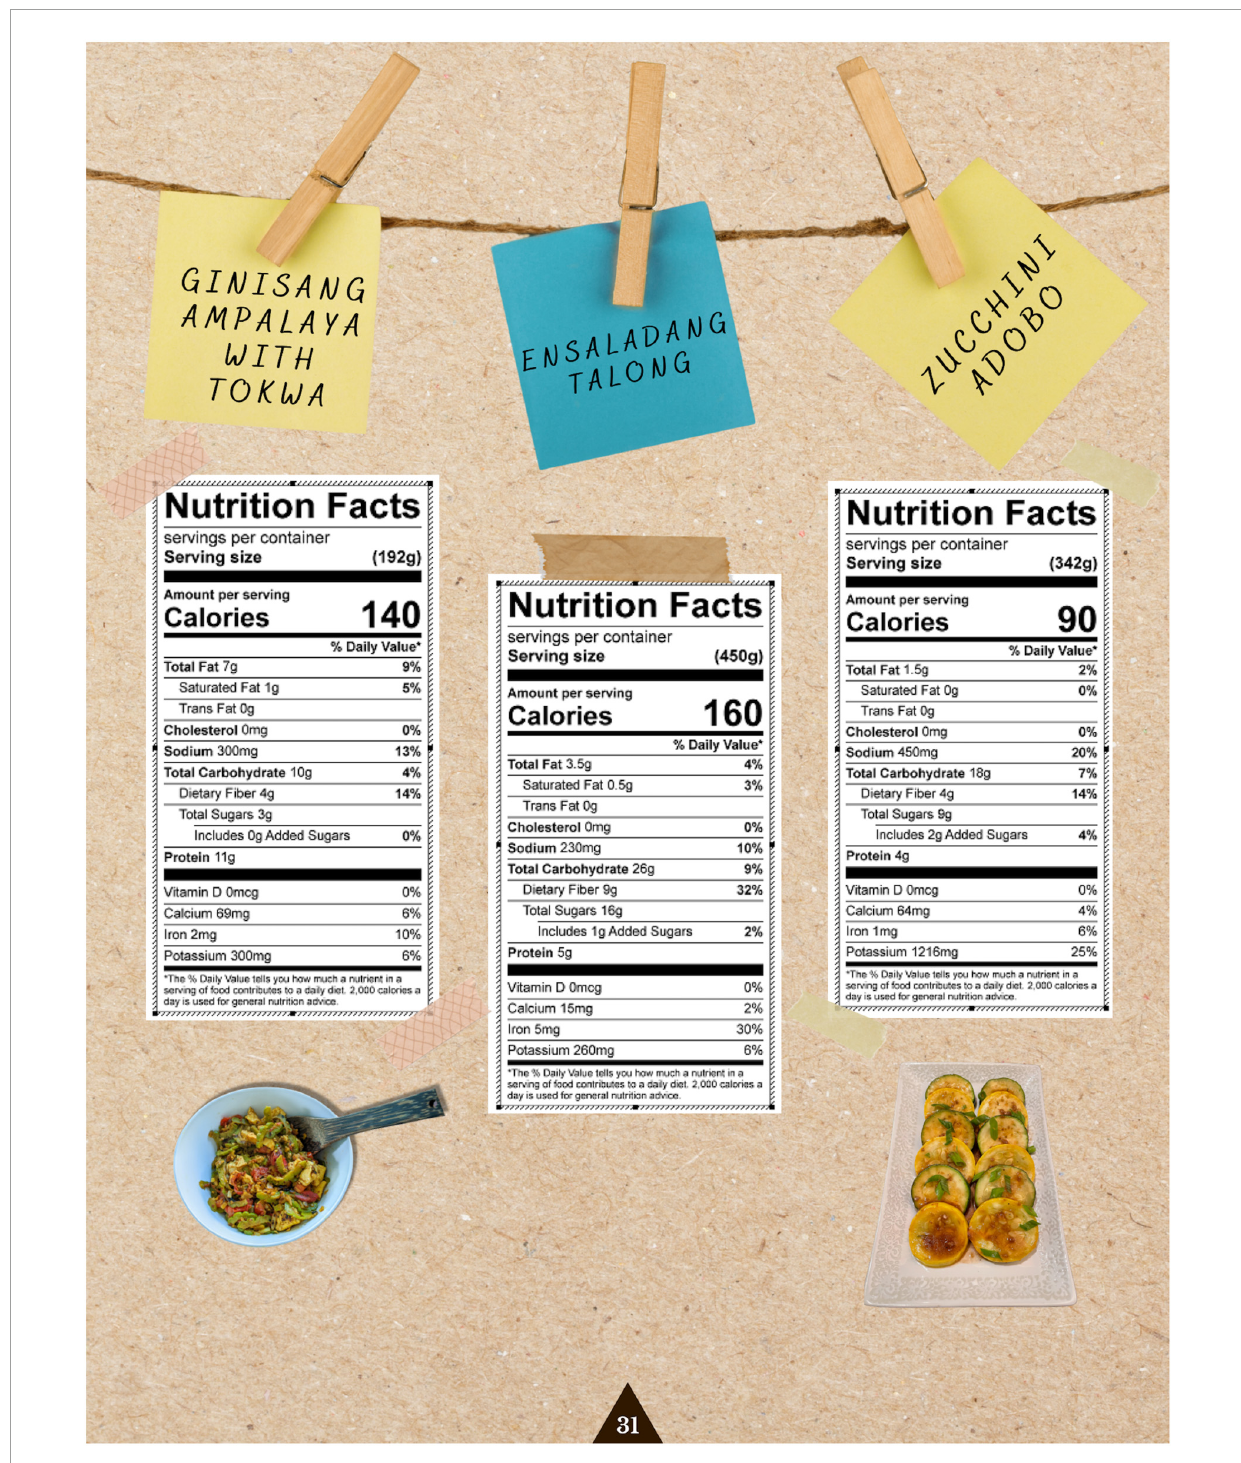
FIGURE3 Nutrition labels of three recipes created by a Registered Dietitian. The page was formatted with images of the dish and casual design elements to be more approachable and understandable for our readers.